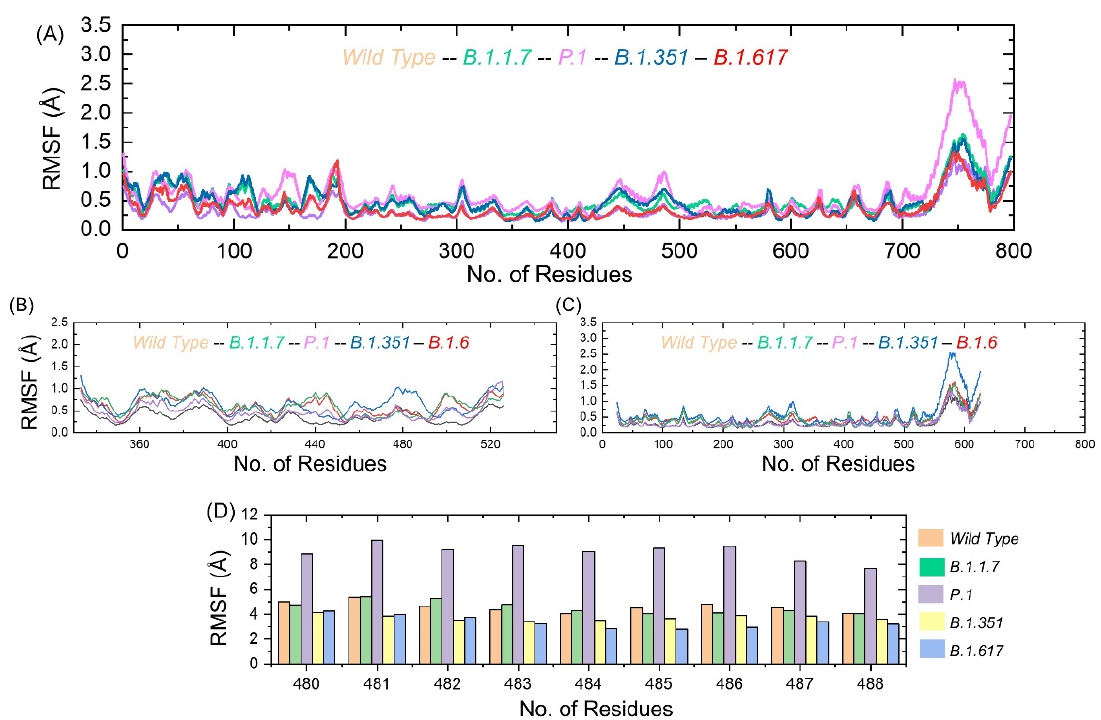
Figure 7. Residual flexibility of GRP78 and spike RBD of the wild-type and variants calculated as RMSF. ( A ) shows the RMSF of wild-type and variants RBD-GRP78 complex; ( B ) shows the RMSF of RBD only; ( C ) shows the RMSF of GRP78 only; ( D ) shows the RMSF of the region C480–C488.